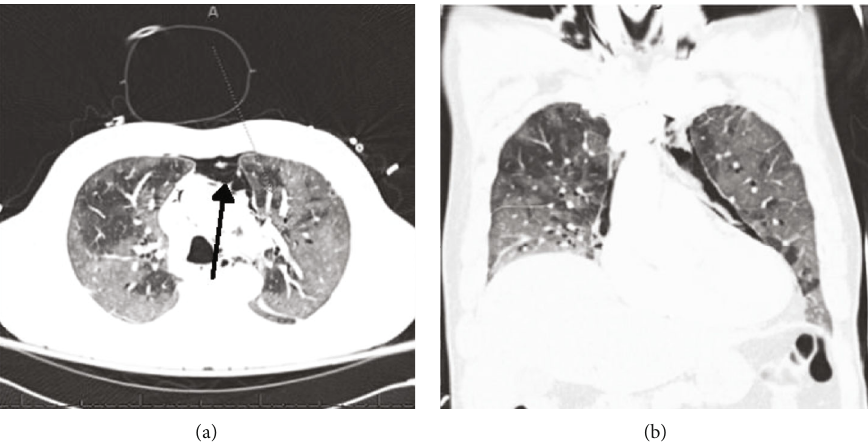
Figure 4: (a) Axial and (b) coronal views of computed tomography of chest. (a) Shows bilateral di ff use ground glass opacities, areas of low attenuation on right lung, anterior pneumomediastinum (arrow). (b) Shows pneumomediastinum and di ff use bilateral in fi ltrates.